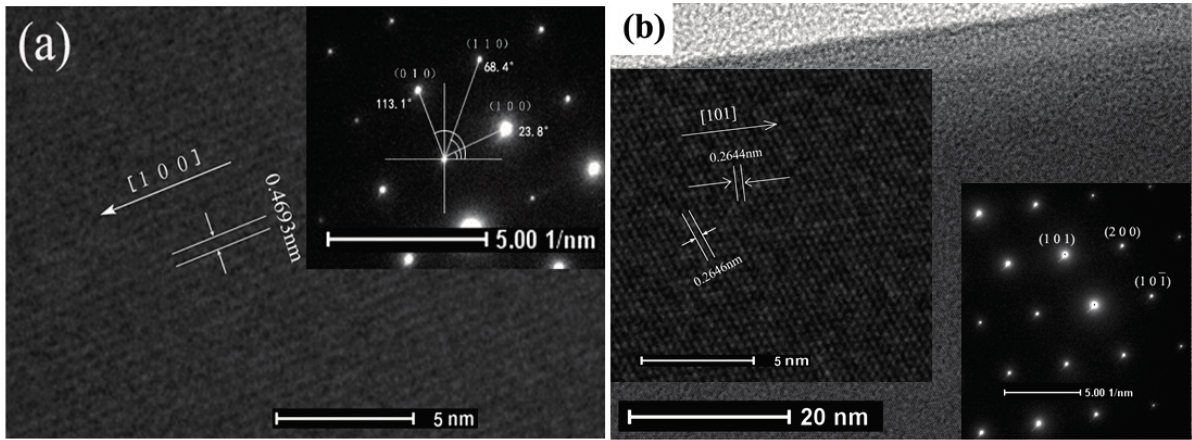
Figure 3. The HRTEM and SEAD images of pure SnO 2 NBs ( a ) and La-SnO 2 NBs ( b ). Figure 4 present typical I–V curves when the devices were in air at room temperature. The approximately linear shape of the curves reveals good Ohmic contacts of SnO 2 NB/La-SnO 2 NB with the electrodes. The slope of pure SnO 2 NB is less than that of the La-SnO 2 NB. The resistance of La-SnO 2 NB is about 2.05 × 10 8 Ω and that of pure SnO 2 NB is about 2.08 × 10 9 Ω , indicating that the resistance of SnO 2 is greatly reduced after doping. Figure 4b presents a typical optical microscope Au electrodes.